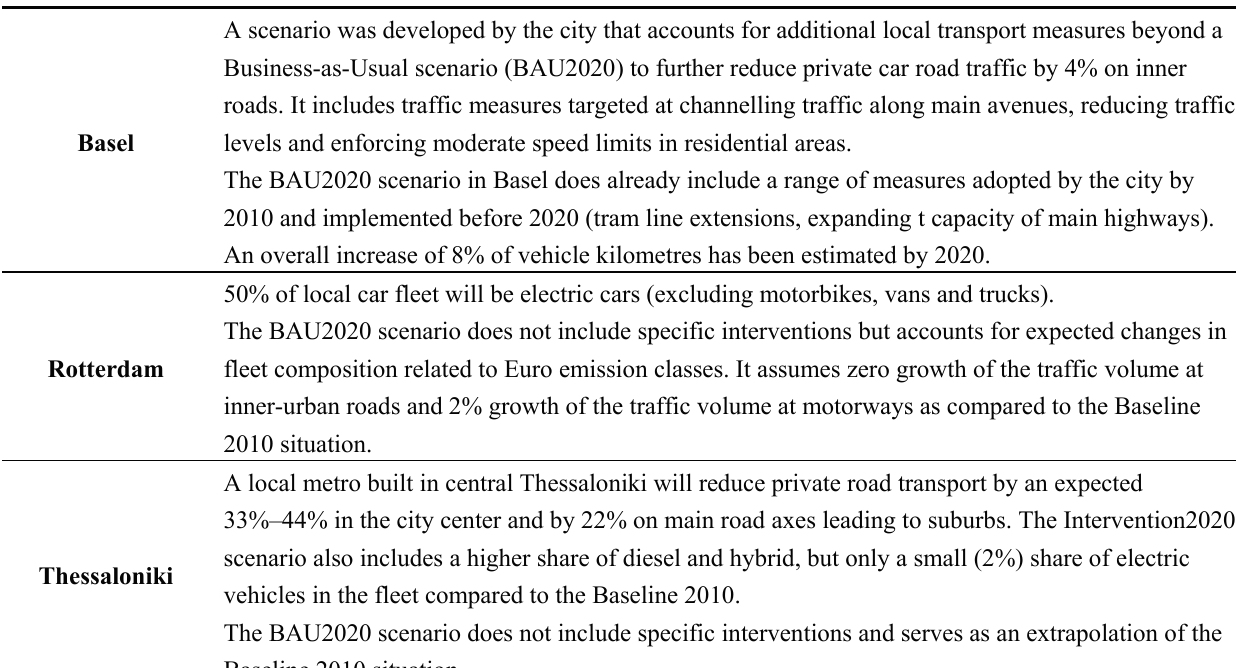
Table 1. Interventions to be implemented in case study cities by